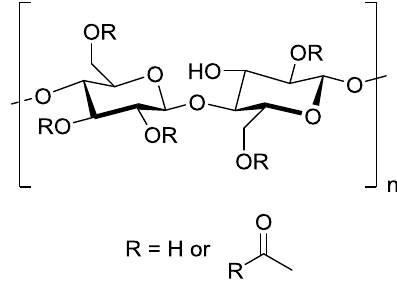
Figure 7. Chemical structure of cellulose acetate.